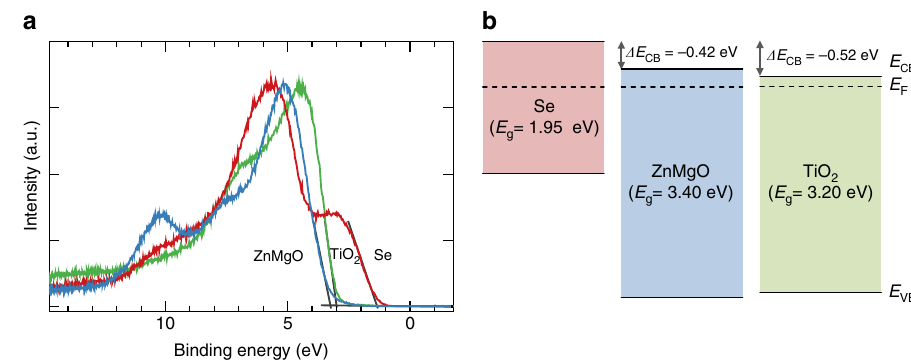
Fig. 4 a Femtosecond ultraviolet photoelectron spectroscopy (fs-UPS) spectra of Se ( red ), TiO 2 ( green ), and ZnMgO ( blue ) under fl at-band conditions. b Valence band and conduction band lineups extracted from the fs-UPS and optical absorption spectra